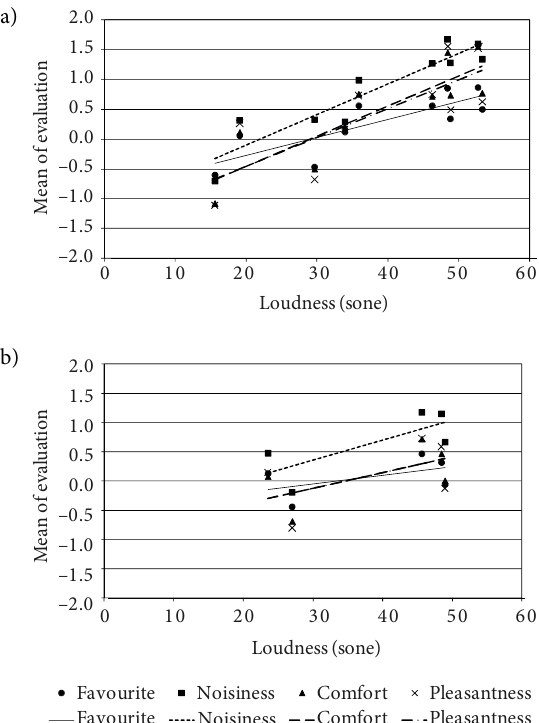
b)Fig. 4. Correlations between loudness and the subjective evaluations of favourite, noisiness, comfort, and pleasantness for (a) single sound, (b) combined sounds